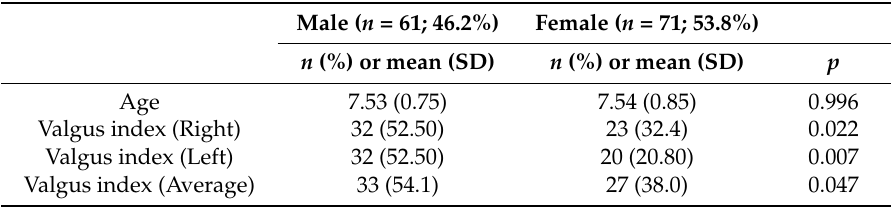
Table 1. Characteristics of the sample. SD: Standard